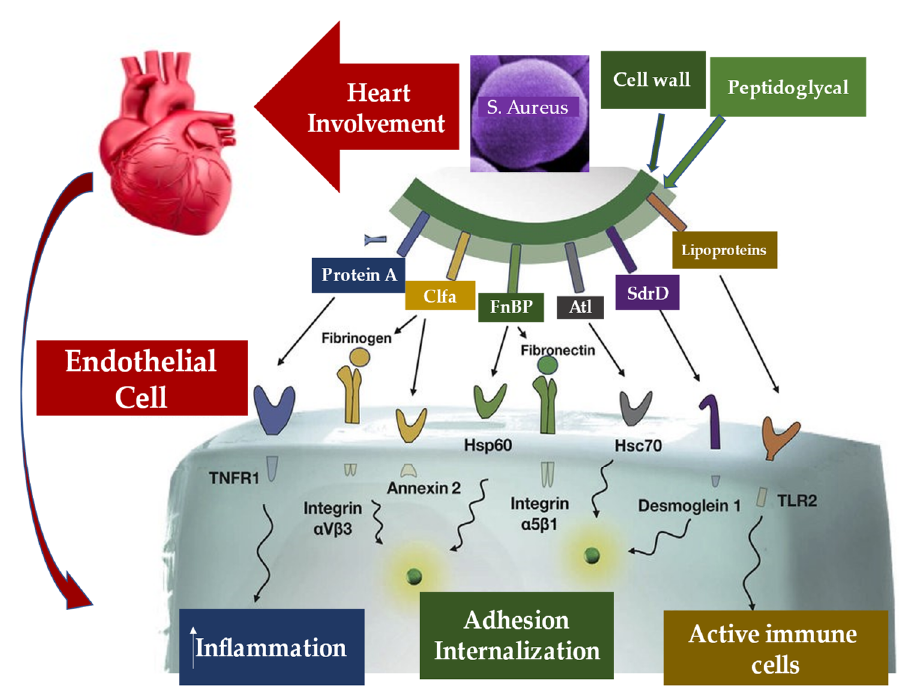
Figure 9. The substantial pathogenic action of Staphylococcus Aureus is depicted during infection of the heart and endothelial cells. The process involves three crucial stages: an increase in the inflammatory response (blue box), adhesion and internalization of the pathogen (green box), and the development of an active immune response (brown box). The external envelope of S. Aureus , consisting of the cell wall and peptidoglycans, expresses the different molecules involved in the three physopathological processes. Abbreviations: Atl, autolysin; Clfa, clumping factor A: FnBP, fibronectin binding protein; Hsc70, Heat shock cognate; Hsp60, Heat shock protein; SdrD, Serine Aspartate repeat containing protein D; TLR2, Toll-like receptor 2; TNFR1, tumor necrosis factor receptor 1.